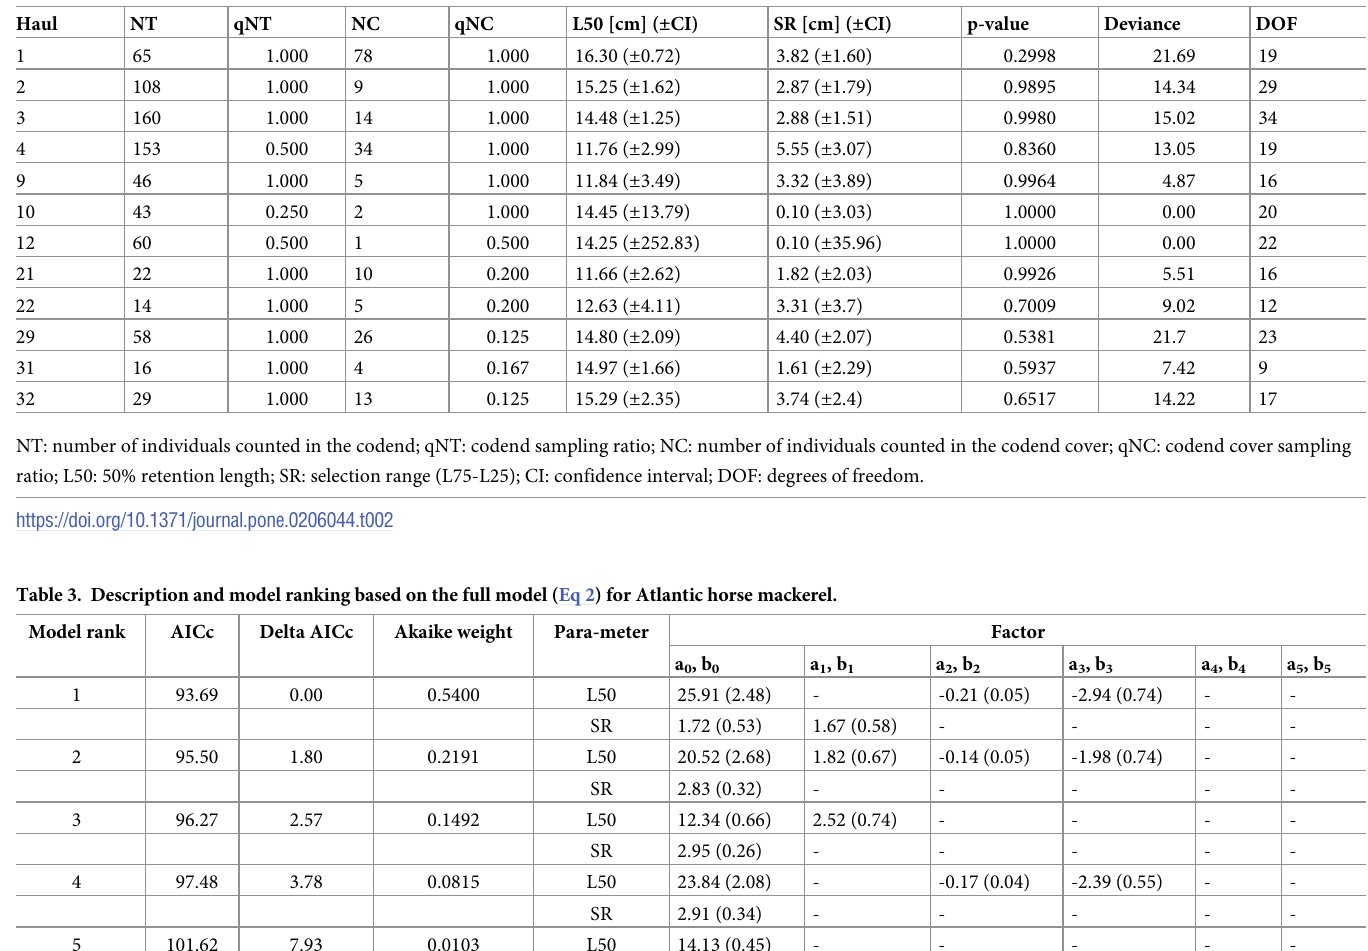
Table 2. Estimated selection parameters and fit statistics for Atlantic horse mackerel (12 hauls).